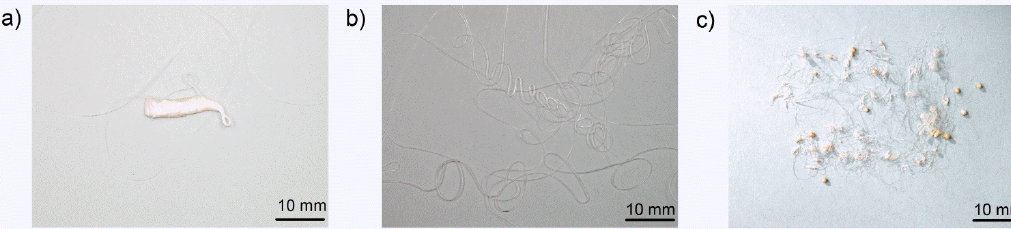
Figure 3. Mass loss as a function of time for: ( a ) PBT HB at various furnace temperatures; and ( b ) PBT HB, PBT V-2, PBT V-1 and PBT V-0 at 650 °C.